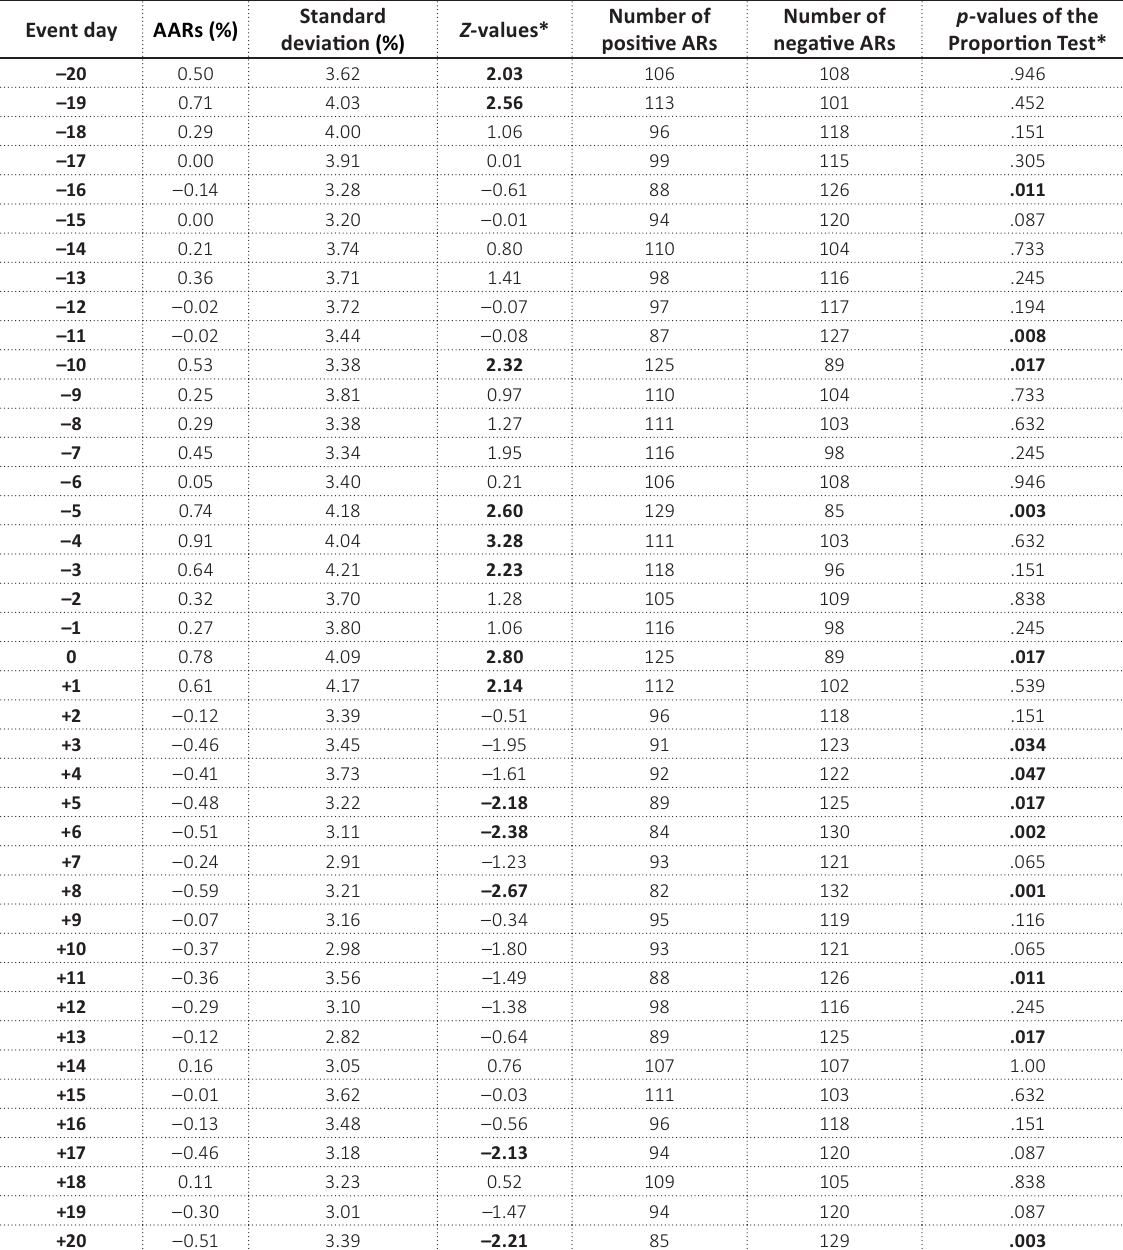
Table 1. Average abnormal returns (AARs) and Z -values (announcement day) Event